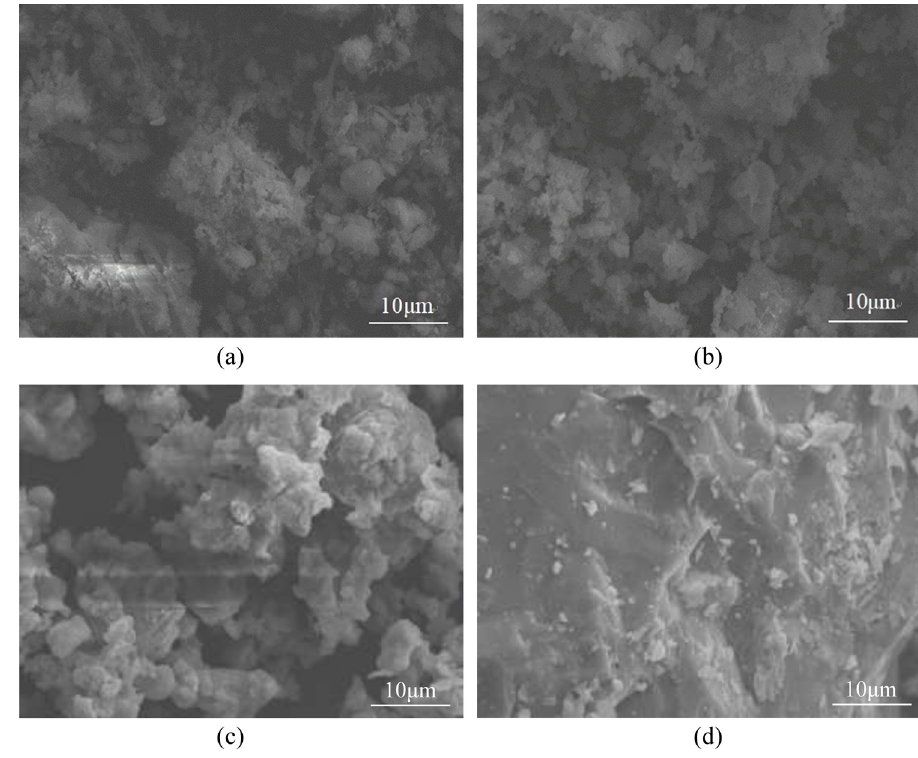
Figure 6: Micromorphology of ashed samples at di ff erent temperatures: ( a ) 873 K, ( b ) 1,073 K, ( c ) 1,273 K, and ( d ) 1,473